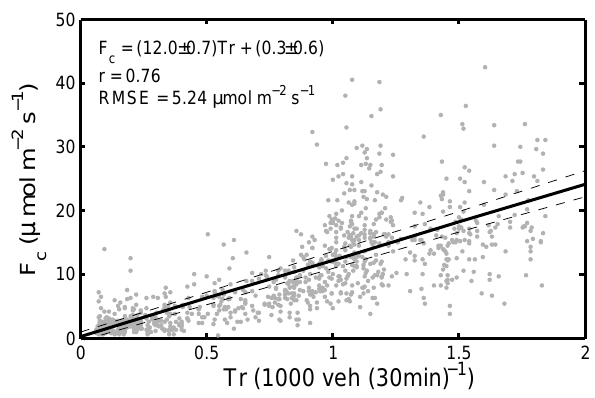
Fig. 9. CO 2 exchange as a function of traffic rate for winter time when ground was covered with snow. The black line shows the lin- ear fit to the data points and dashed lines the error limits for the